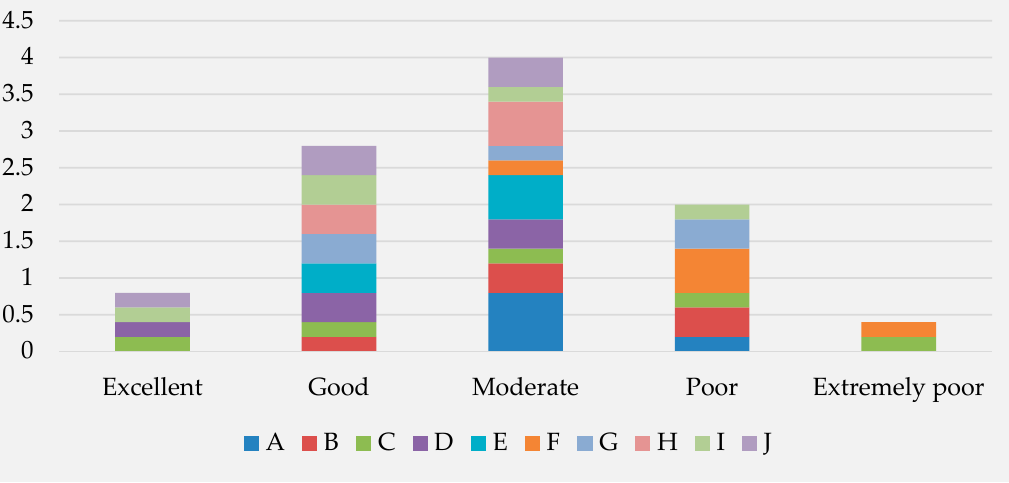
Figure 4. Level distribution of the single-level fuzzy evaluation.